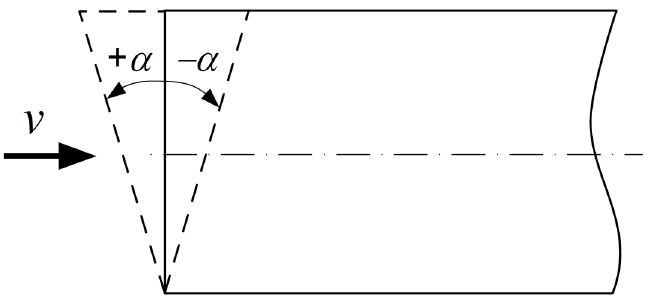
Figure 11. An illustration of the orientation of the positive and negative angles of the incoming current.